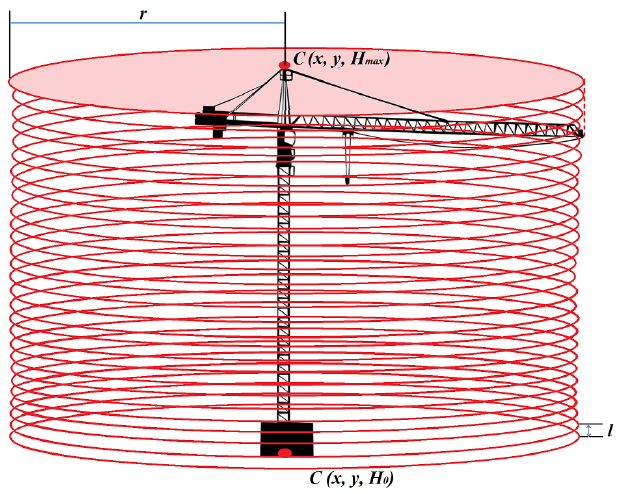
Figure 3. Determination of the centroid of the detected obstacle.